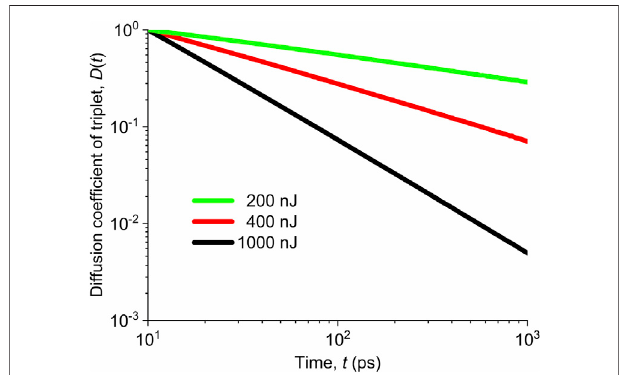
FIGURE 10 | Normalized values of the diffusion coef fi cient of triplets for different pump fl uences marked in the legend.